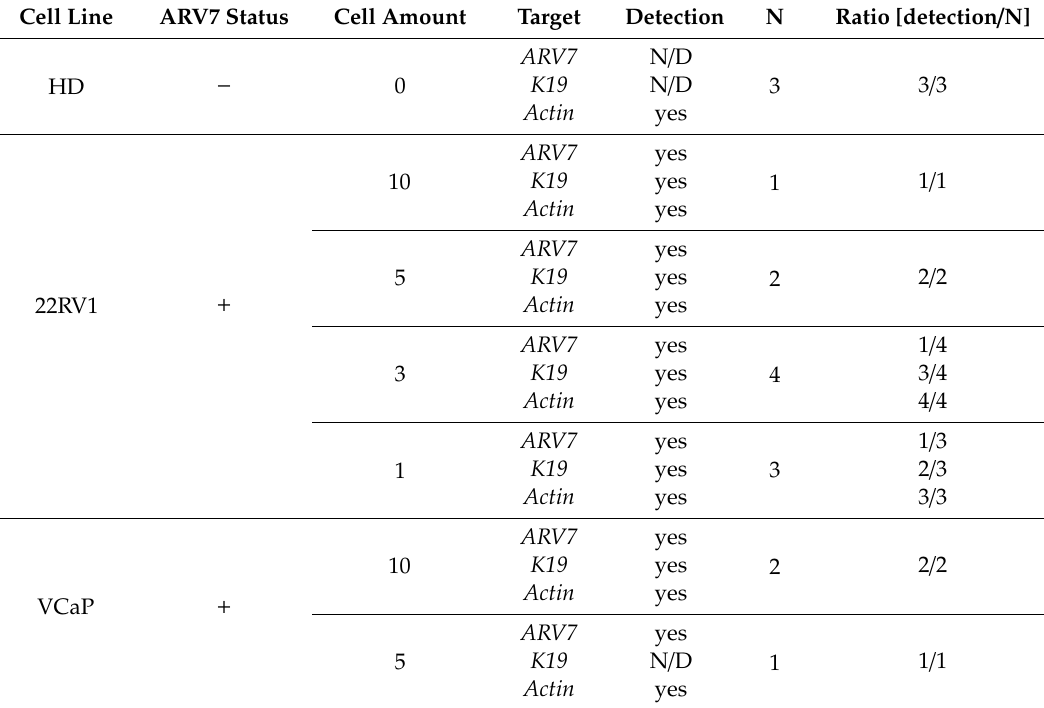
Table 2. Validation of protocol specificity and sensitivity after 24 h. Influence of sample storage on ARV7 detection limits and assay robustness. ARV7 status is highlighted as “ + ” for positive and “ − “ for negative samples. Detection of gene expression was confirmed when at least 2 / 3 triplicates were positive in qPCR analysis. N represents the number of repetitions performed per experimental setting. The ratio is defined as the frequency at which any specific gene was detected out of the N repetitions. N / D signifies no gene expression or gene expression above the set threshold of 35